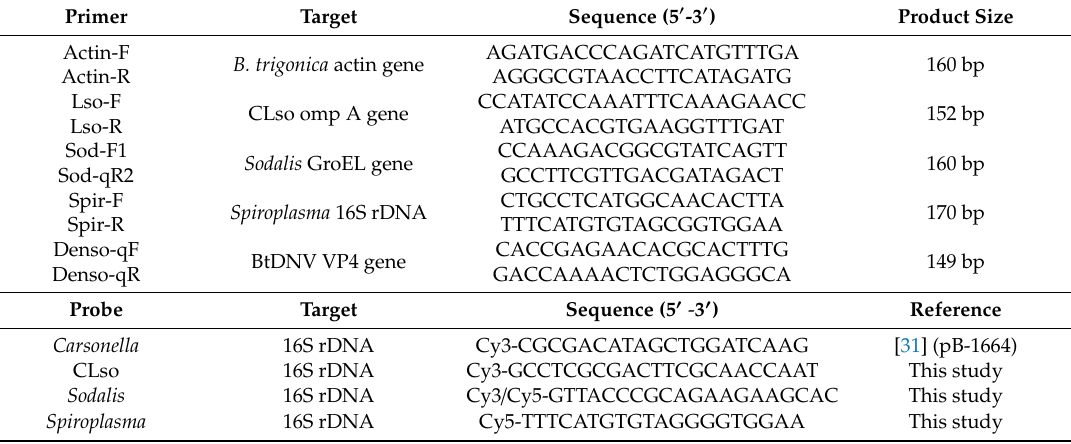
Table 1. Primer and probe sequences used in this study. CLso: Candidatus Liberibacter